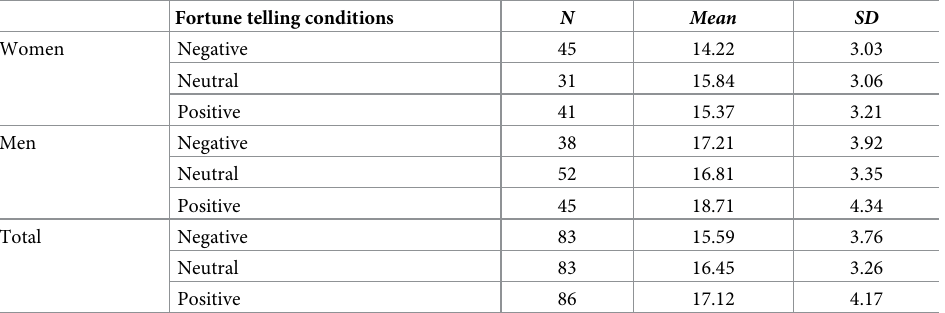
Table 1. Descriptive statistics for financial risk tolerance by gender among different fortune telling conditions in Study